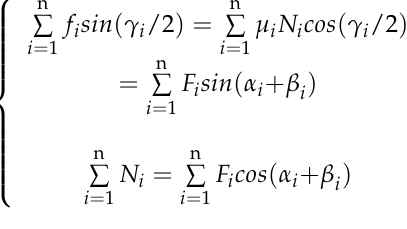
Figure 4. ( a ) The phase images of the gear 1 and gear 2. ( b ) The Poincare maps of the gear 1 and gear 2. ( c ) The phase images of the gear 1 and gear 3. ( d ) The Poincare maps of the gear 1 and gear